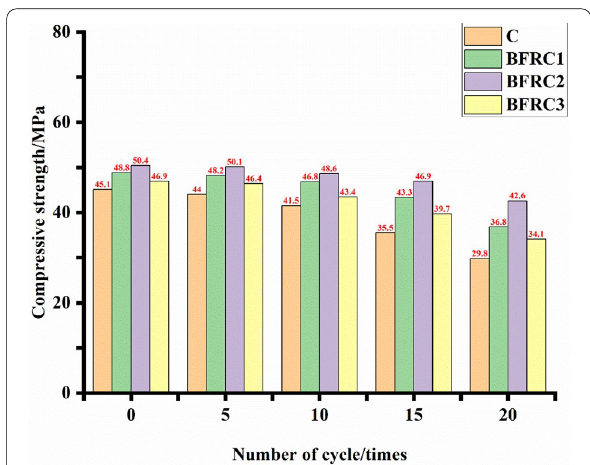
Fig. 5 The compressive strength at different single-side salt-freezing–drying–wetting